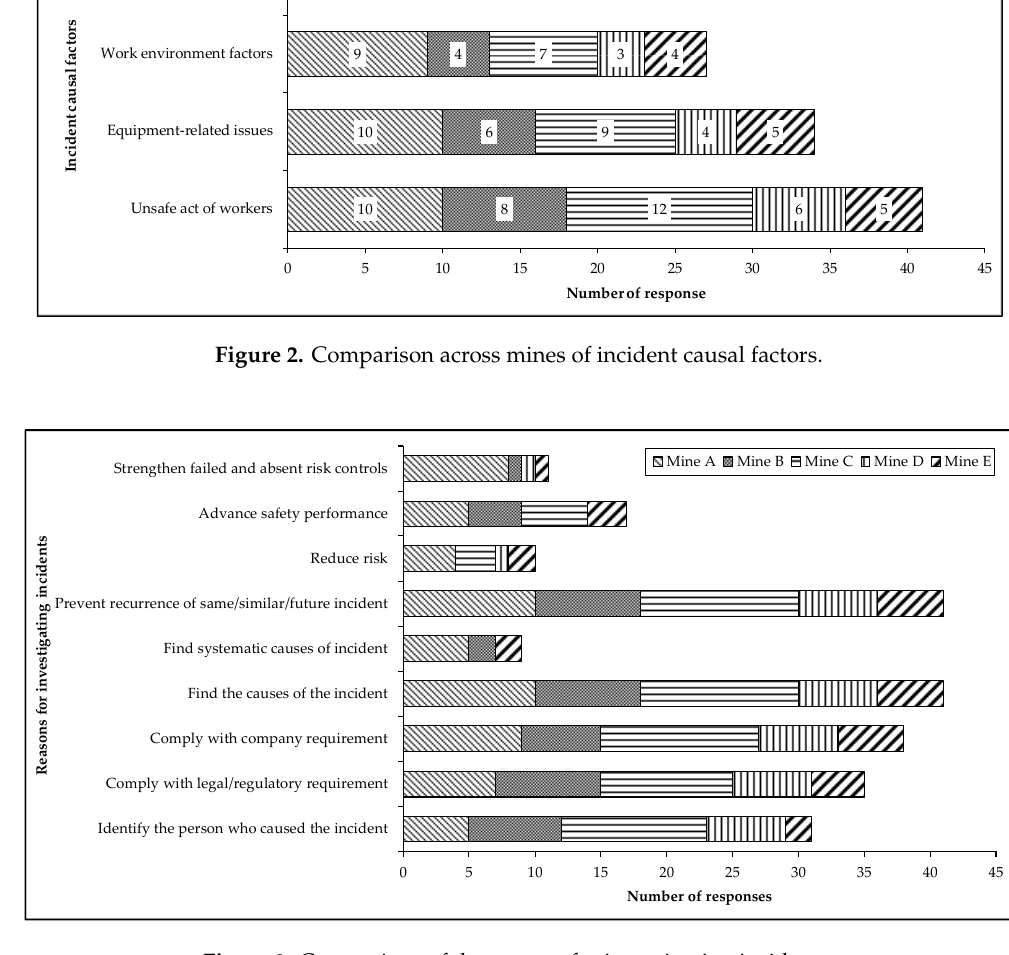
Figure 3. Comparison of the reasons for investigating incidents.